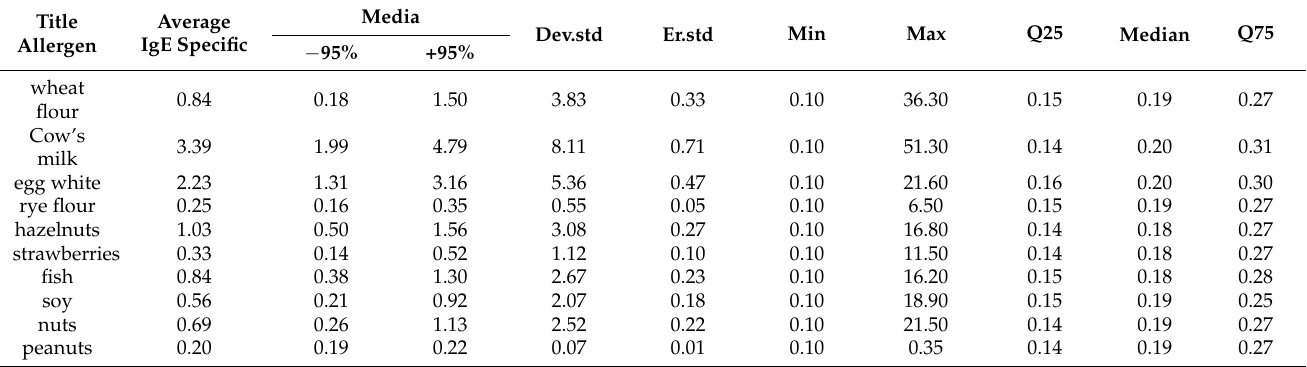
Table 1. Statistical indicators of specific IgE vs. allergen type.